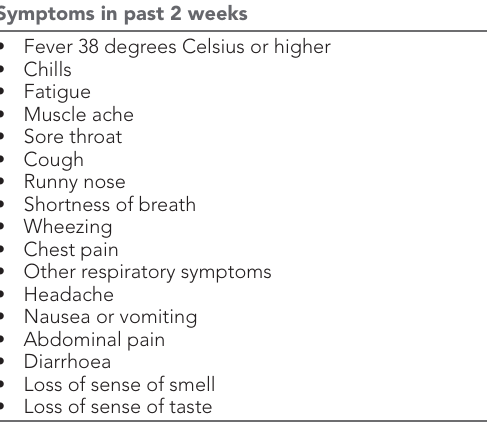
Table 3 COVID-19 symptoms in past 2